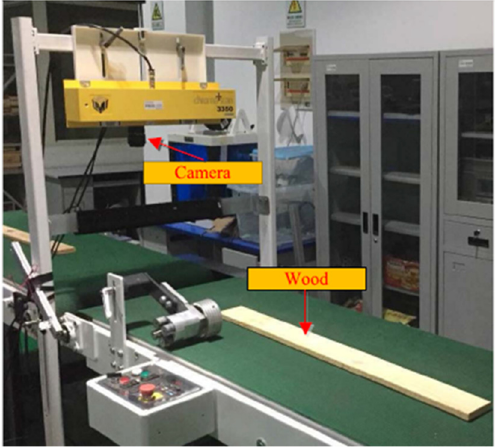
Figure 1. Image acquisition device for solid wood surface defects. Table 1. Software and hardware environment configuration table.